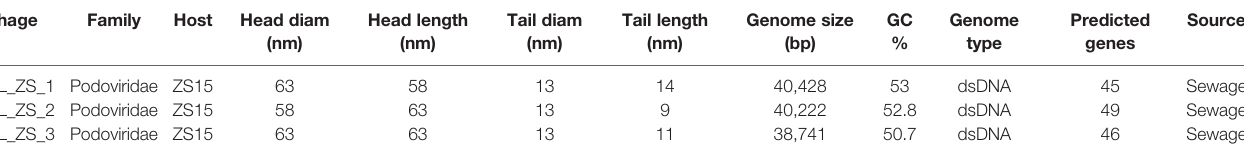
TABLE 2 | Morphological and genomic characterization of phages isolated from the local hospital